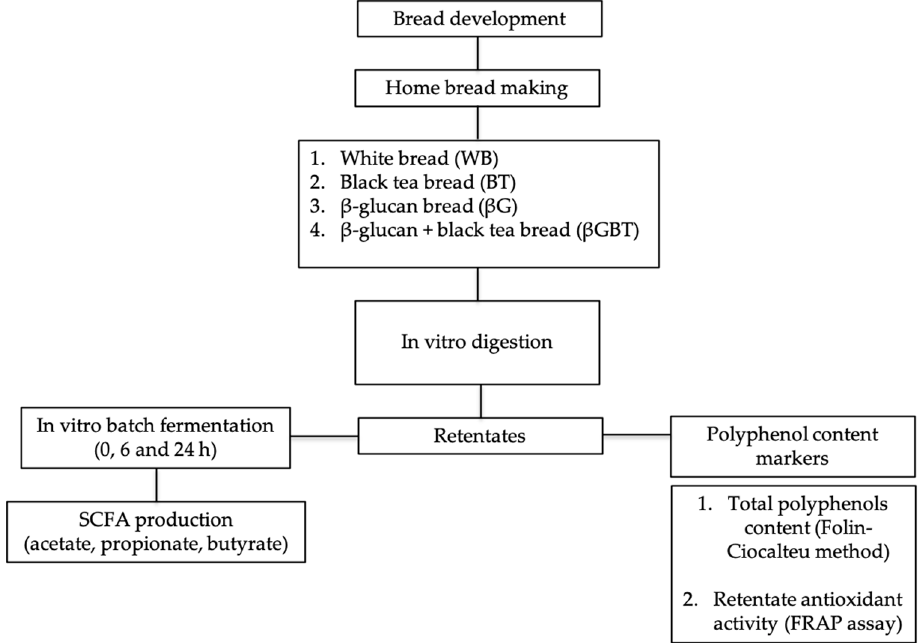
Figure 1 . Study diagram for development of bread, in vitro digestion, and fermentation. SCFA, short chain fatty acids; FRAP, ferric-reducing availability of plasma.